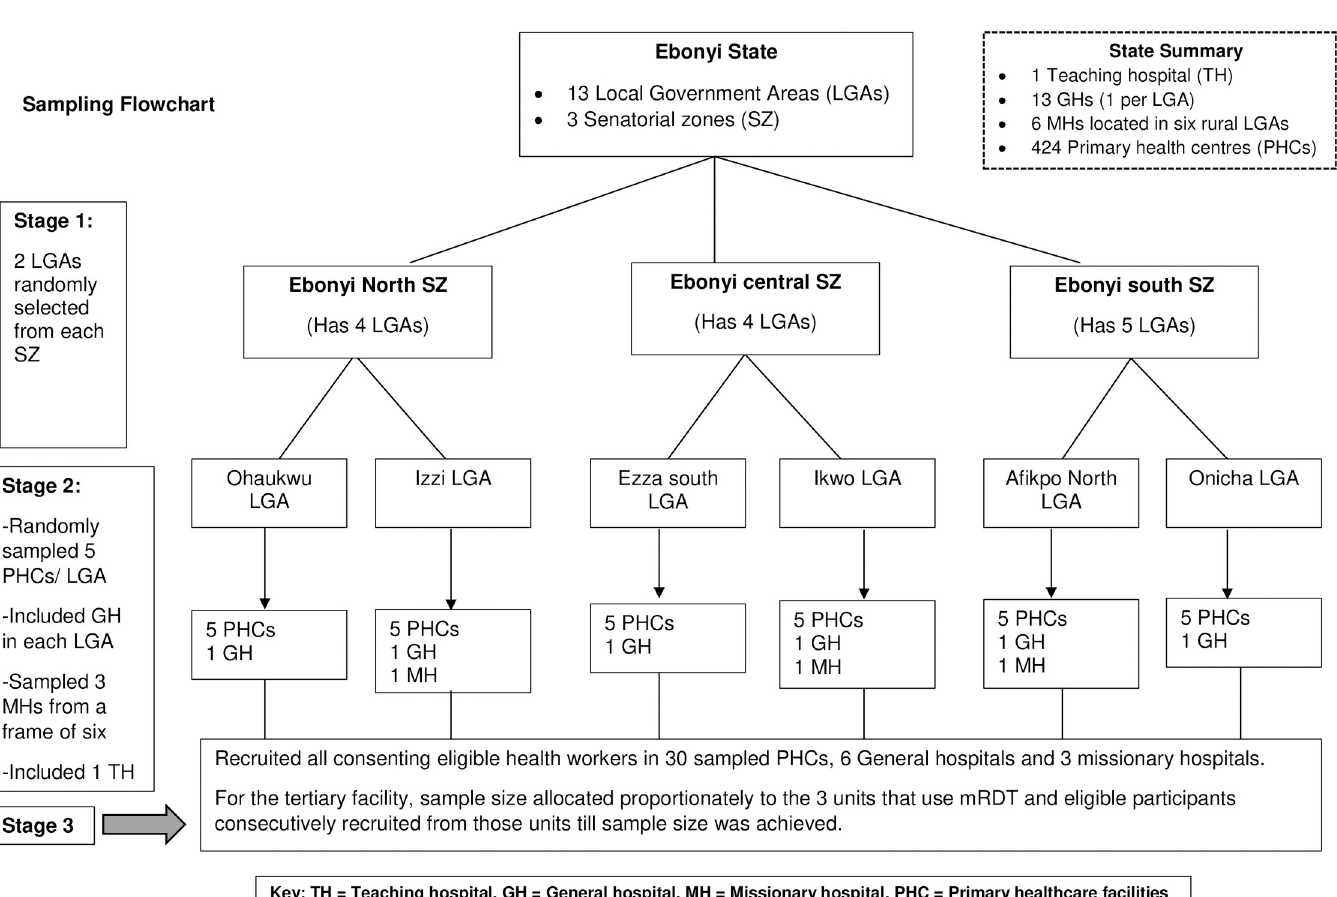
Fig 1. Flowchart of the sampling